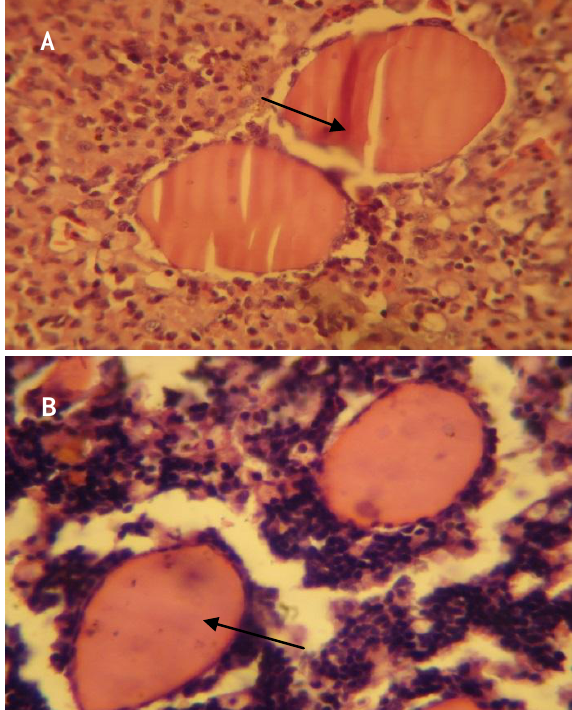
Figure, 3: Kidney in fish thyroid follicles in Carp fish showing non- homogenous coagulated colloid in winter time (A), and diluted homogenous colloid in summer time (B) (arrows). 40X. H and E stain.